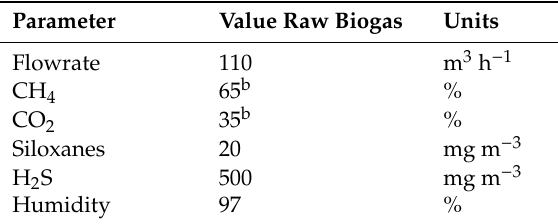
Table 3. Values for the raw biogas generated in the case-study wastewater treatment plant (WWTP) (personal communication).